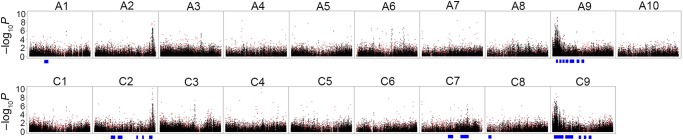
Associative transcriptomics for seed glucosinolate content. These plots are based on the association results in 101 lines using either 144,131 SNPs or 100,534 GEMs. Each dot represents a SNP (black) or a GEM (red). Blue bar beneath chromosome pseudomolecule indicates the confident interval of a QTL for total seed glucosinolate content reported.39